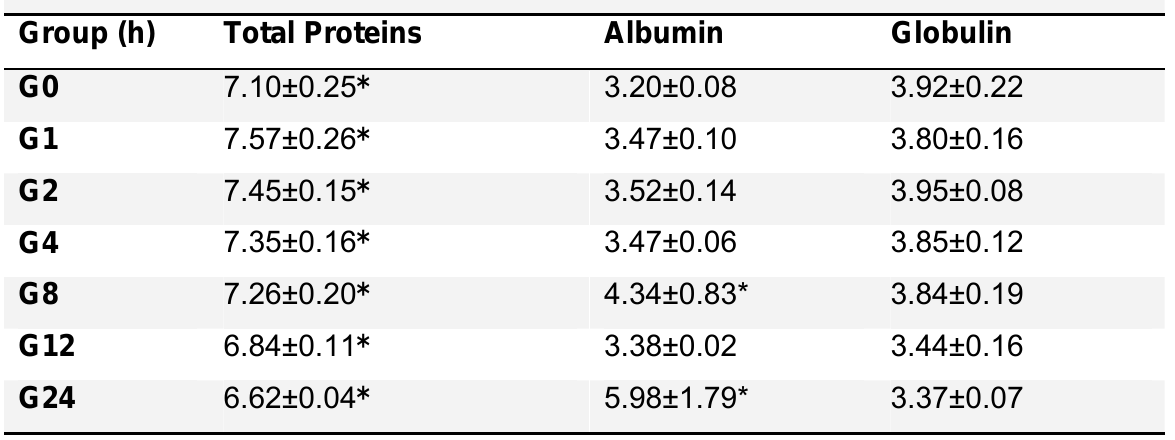
Table 2. Effects of a single sc injection of Androctonus crassicauda venom on the levels of serum total bilirubin (mg/dl), direct bilirubin (mg/dl), urea (mg/dl), creatinine (mg/dl) and uric acid (mg/dl) in rats at the 1 st (G1), 2 nd (G2), 4 th (G4), 8 th (G8), 12 th (G12), and 24 th (G24) hours after venom injection. Results are presented as the mean±S.E.